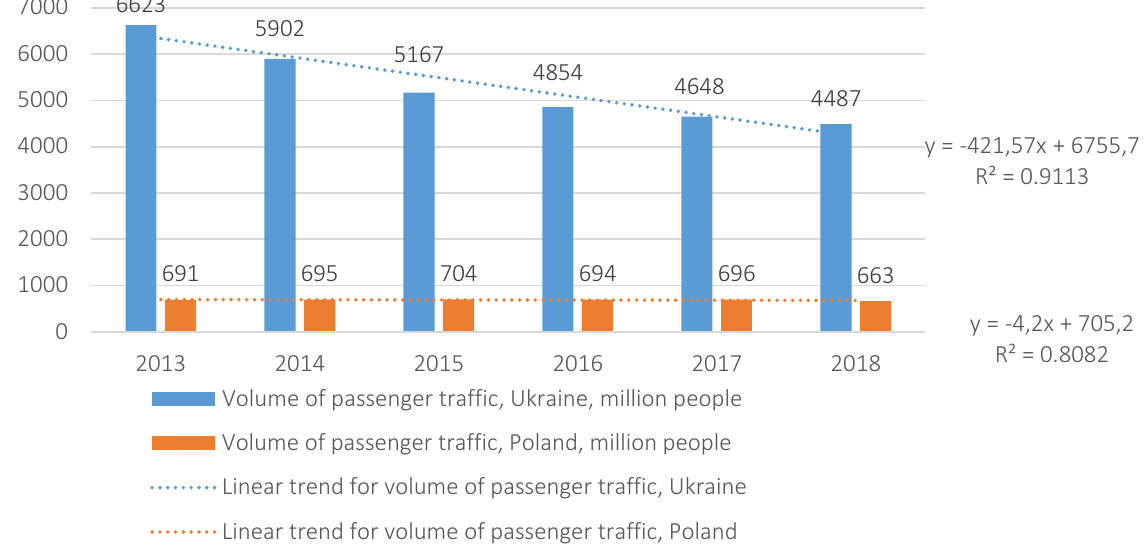
Figure 4. The dynamics of volume of passenger traffic in